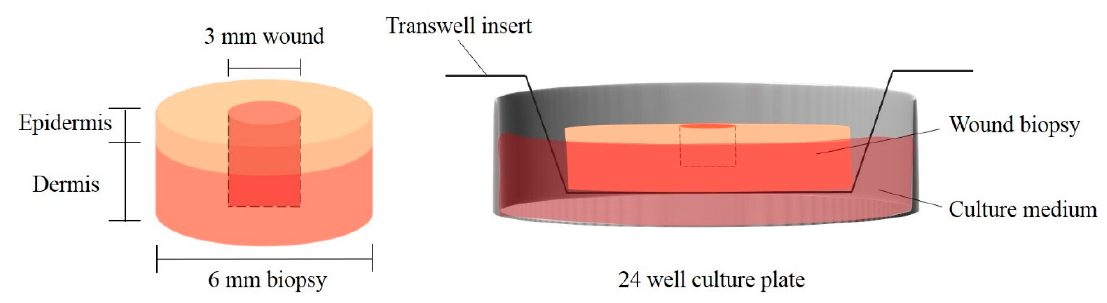
Figure 2. Ex vivo assay scheme.